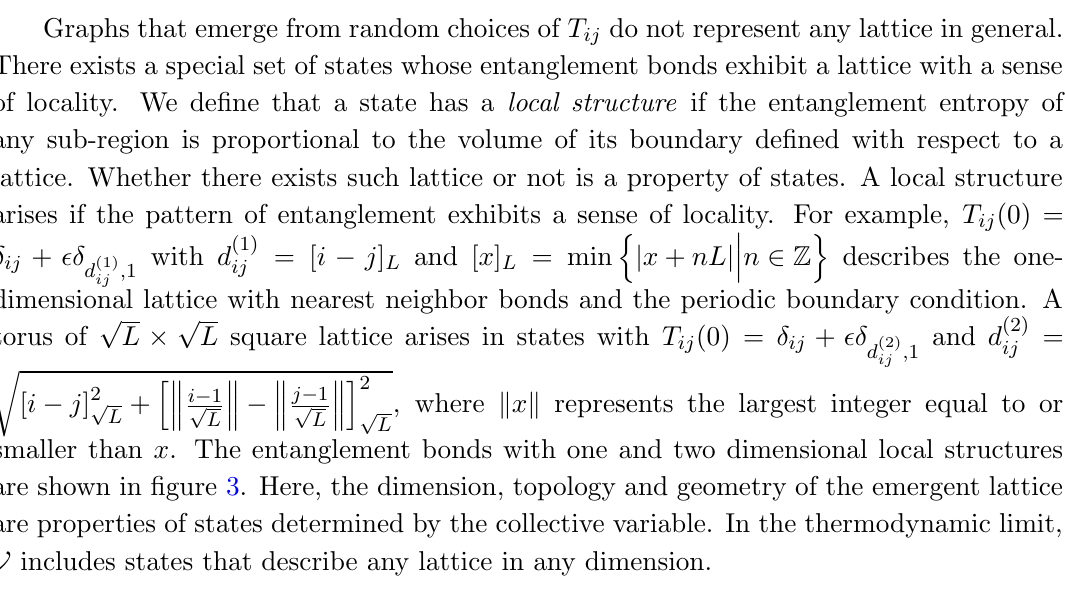
Figure 2 . A set of sites connected by bi-local collective variables, where the thickness of the bond between i; j represents the magnitude of T ij . For generic choices of bi-local (cid:12)elds, graphs do not represent regular